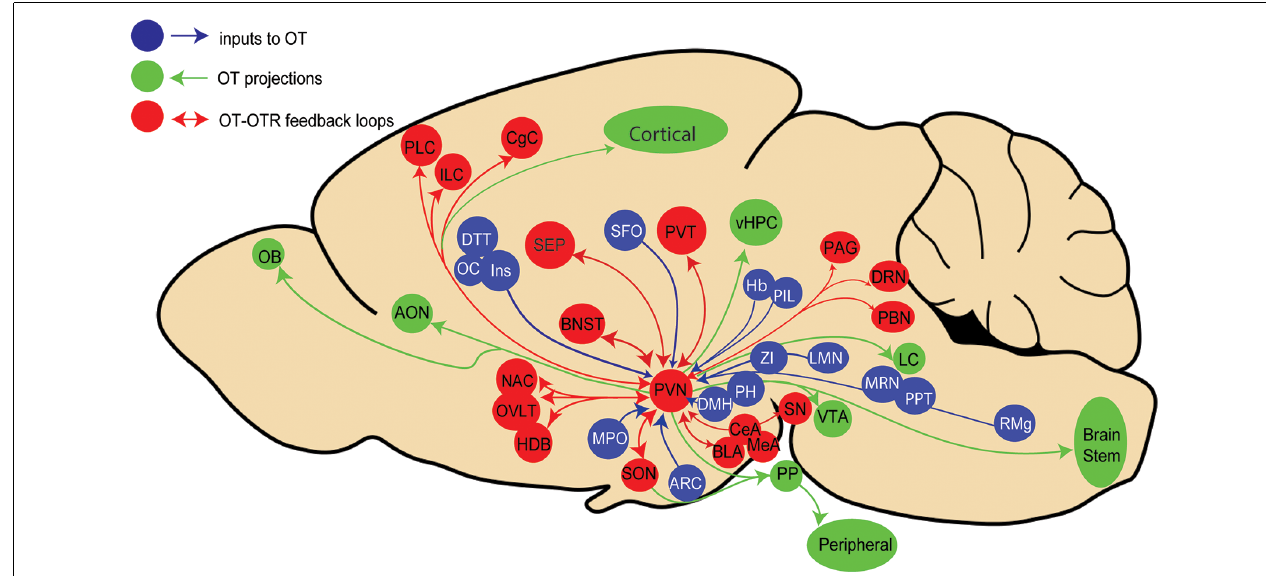
FIGURE 1 | Schema representing known paraventricular (PVN) oxytocin (OT) neurons inputs (blue), outputs (green), and areas providing both inputs to and receiving projections from PVN OT neurons in rats. Brain areas legend: AON, Accessory olfactory nucleus; Amygdala: Amy (central, basolateral and medial amygdala: CeA, BLA, MeA), ARC, Arcuate hypothalamic nucleus; BNST, Bed nucleus of stria terminalis; CgC, Cingulate cortex; Cl, Claustrum; DRN, Dorsal raphe nucleus; DTT, Dorsal tenia tecta; DMH, Dorsomedial hypothalamic area; Hb, Habenular nucleus; HDB, Horizontal limb of diagonal band nucleus; ILC, Infralimbic cortex; Ins, Insular cortex; LH, Lateral hypothalamic area; LMN, Lateral lemniscus nucleus; SEP, Lateral septal nucleus; LC, Locus Coeruleus; MMB, Mammillary body; MPO, Medial preoptic area; MRN, Median raphe nucleus; NAC, Nucleus accumbens; OB, Olfactory bulb; OC, Orbital cortex; PBN, Parabrachial nucleus; PVT, Paraventricular thalamus; PPT, Pedunculopontine tegmental nucleus; PAG, Periaqueductal gray area; PH, Posterior hypothalamic nucleus; PIL, Posterior intralaminar thalamus; PLC, Prelimbic cortex; PP, Posterior Pituitary; RMg, Raphe magnus nucleus; SFO, Subfornical organ; SN, Substancia nigra; OVLT, Vascular organ of lamina terminalis: vHPC, ventral hippocampus; VTA, Ventral tegme ZI, Zona incerta.